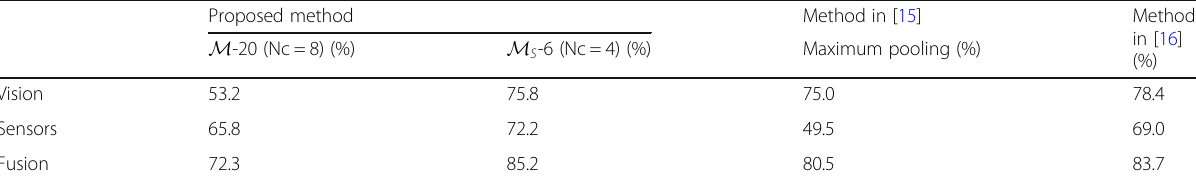
Table 11 Comparison of different methods applied to the same dataset Proposed method